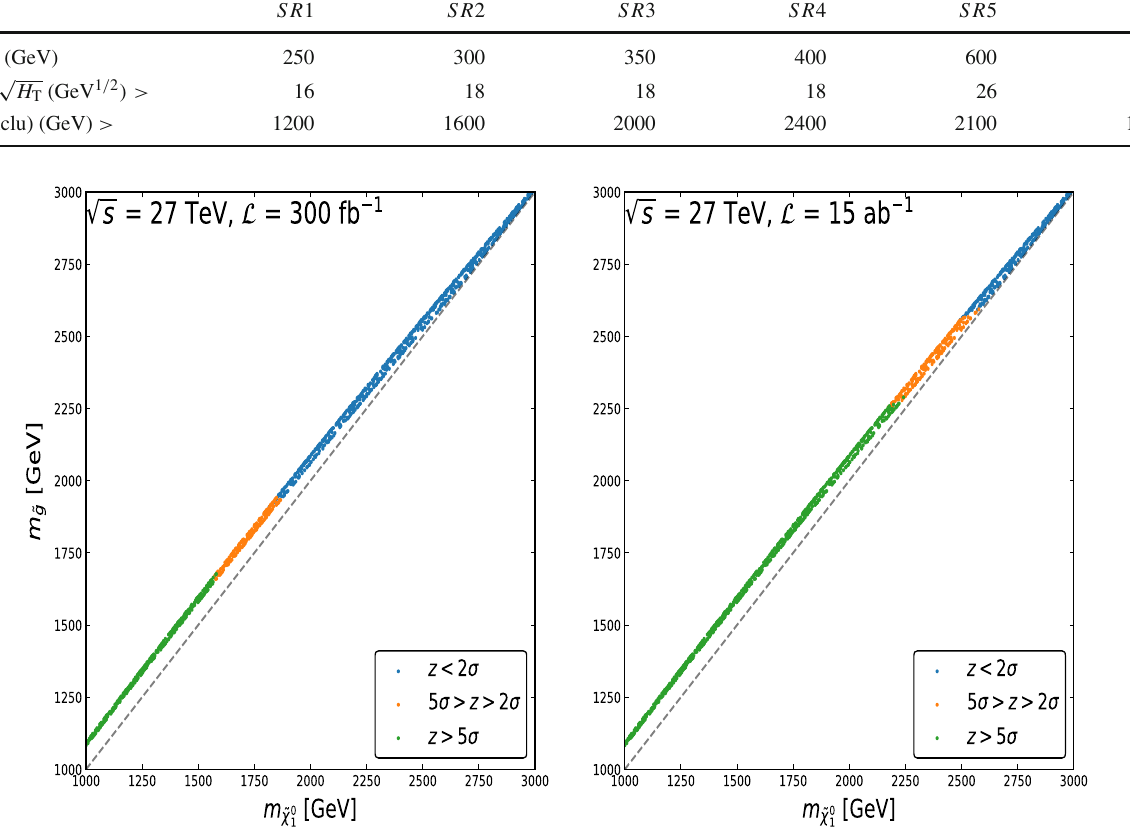
Fig. 5 Thestatisticalsignificance Z ofthemultijetsplusmissingtrans- verse energy events from the process pp → ˜ g ˜ g + X for the gluino coan- nihilation at the HE-LHC with the integrated luminosity L = 300 fb − 1